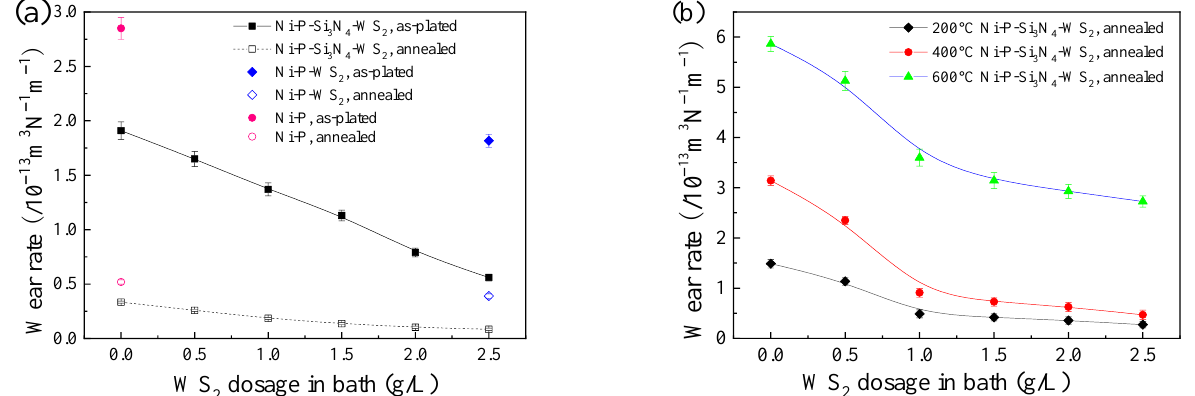
Figure 10. Wear rate of Ni-based coatings with WS 2 dosage in bath at various operating temperatures: ( a ) room temperature; ( b ) 200, 400, and 600 °C.